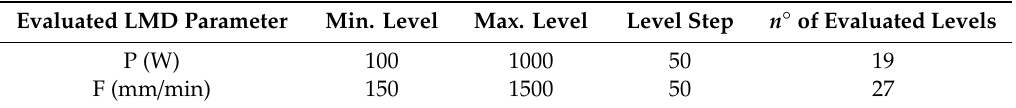
Table 1. Full factorial design of experiments.